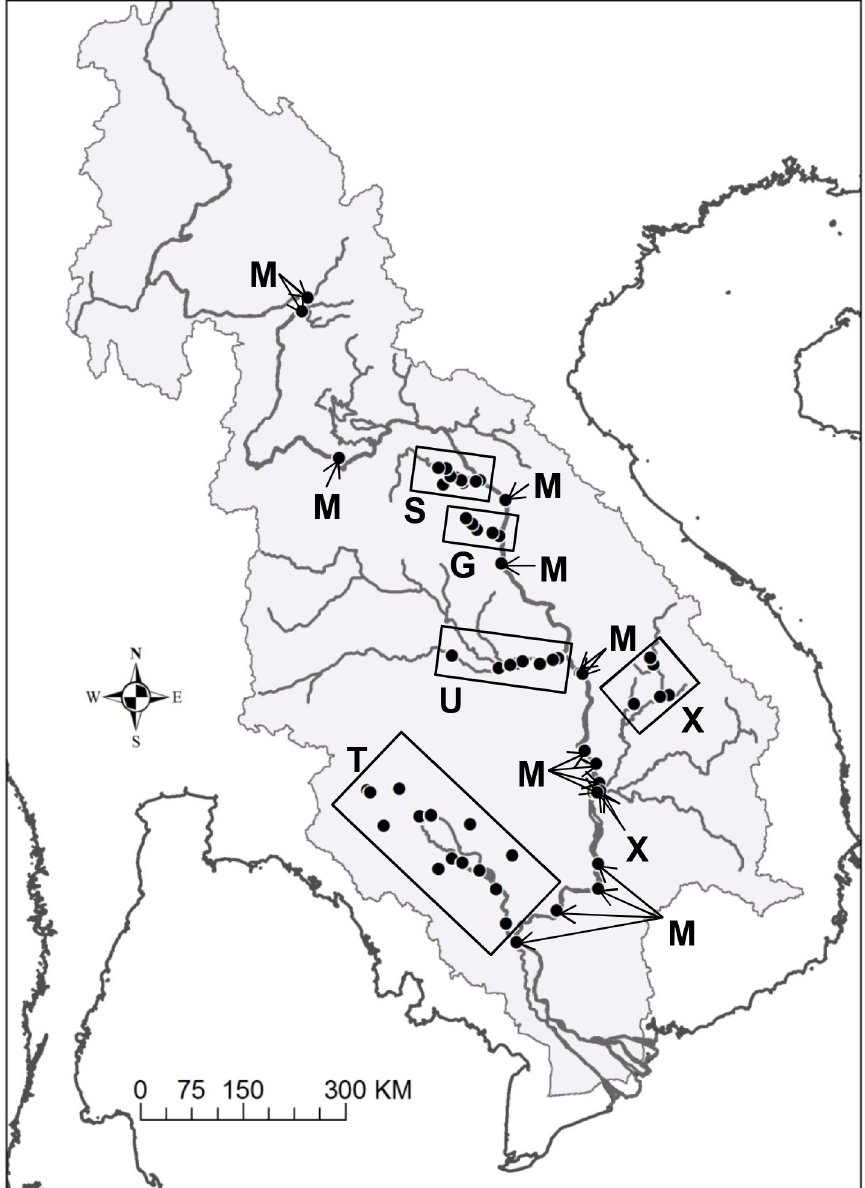
Figure 2. Water sampling sites in six regions. S= Songkhram, G= Gam, U= Mun, X= Xekong, T= Tonle Sap and M= Mekong mainstream.